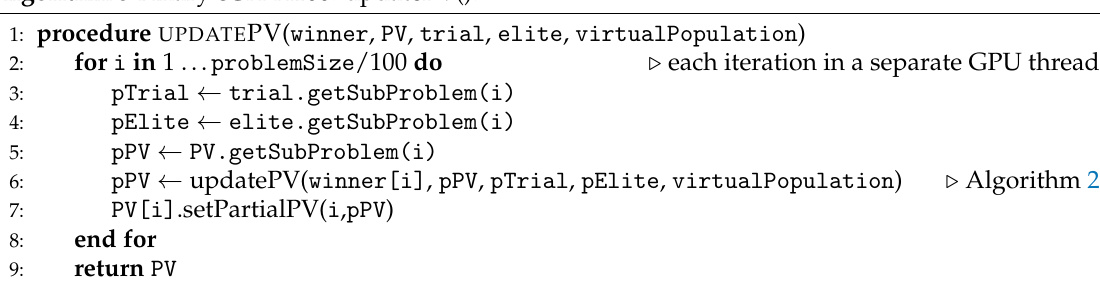
Algorithm 5 Binary cGA-A100: